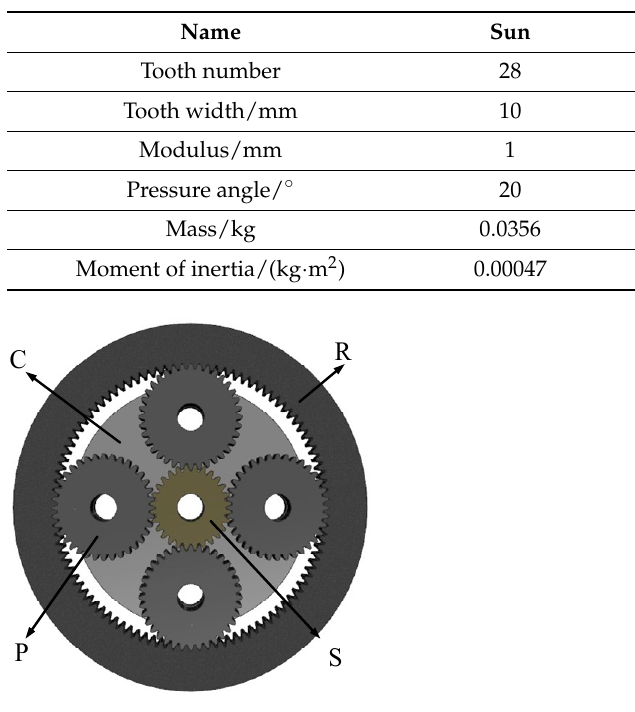
Table 1. Planetary gear transmission system parameters.